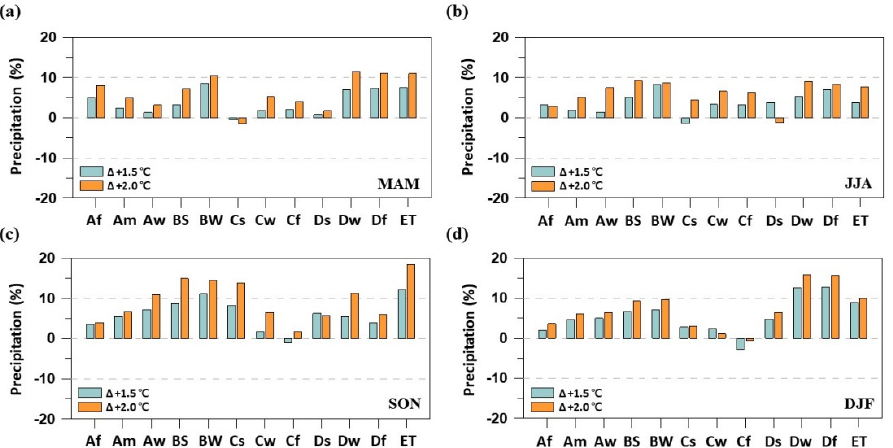
Figure 13. Relative changes in ( a – d ) seasonal mean precipitation based on the MME of 5 GCMs under reference (REF) and future (+1.5 °C and +2.0 °C) climate scenarios for 12 climate zones.